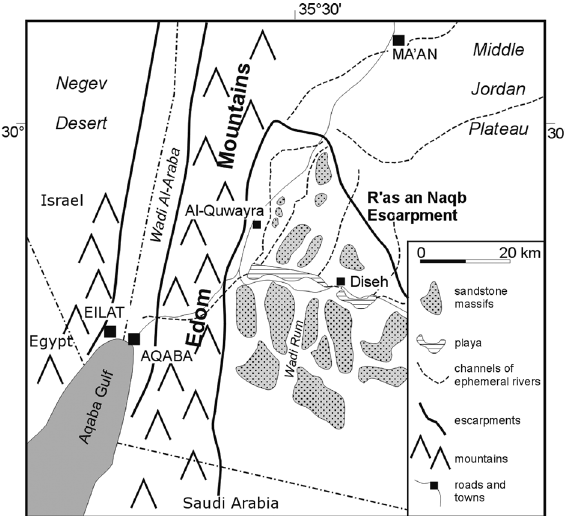
Fig. 1. Location of the sandstone terrain in south-west